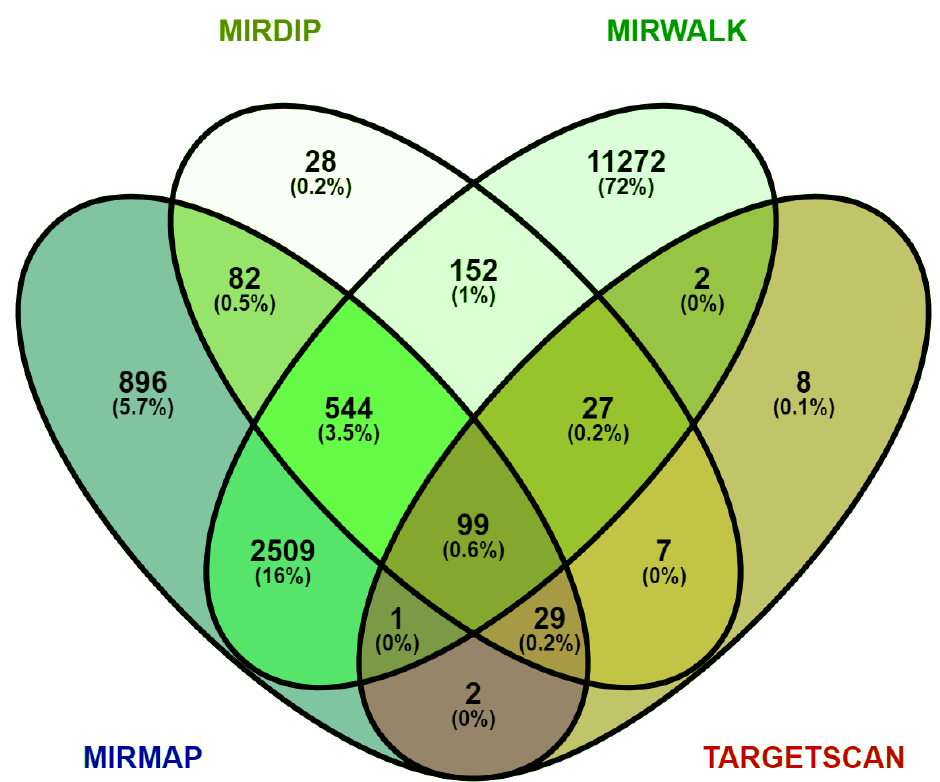
Figure 2. Venn diagram showing overlapping genes between four target predictive databases, i.e., TargetScan, miRWalk, mirDIP, and miRmap. For each miRNA, target genes were retrieved using these four databases; each database showed some different target genes, but we extracted the common genes that were validated in all databases. Abbreviations: MiRNAs: